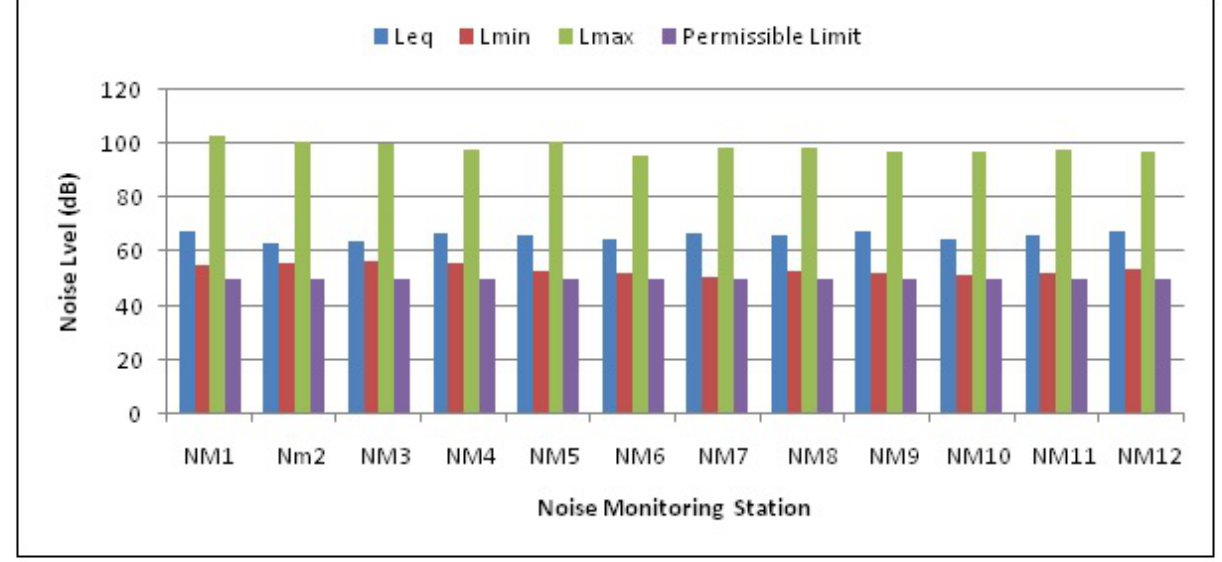
Figure 6: Hourly average variation of Leq (A), Lmax, Lmin and Permissible noise level at study area in day time